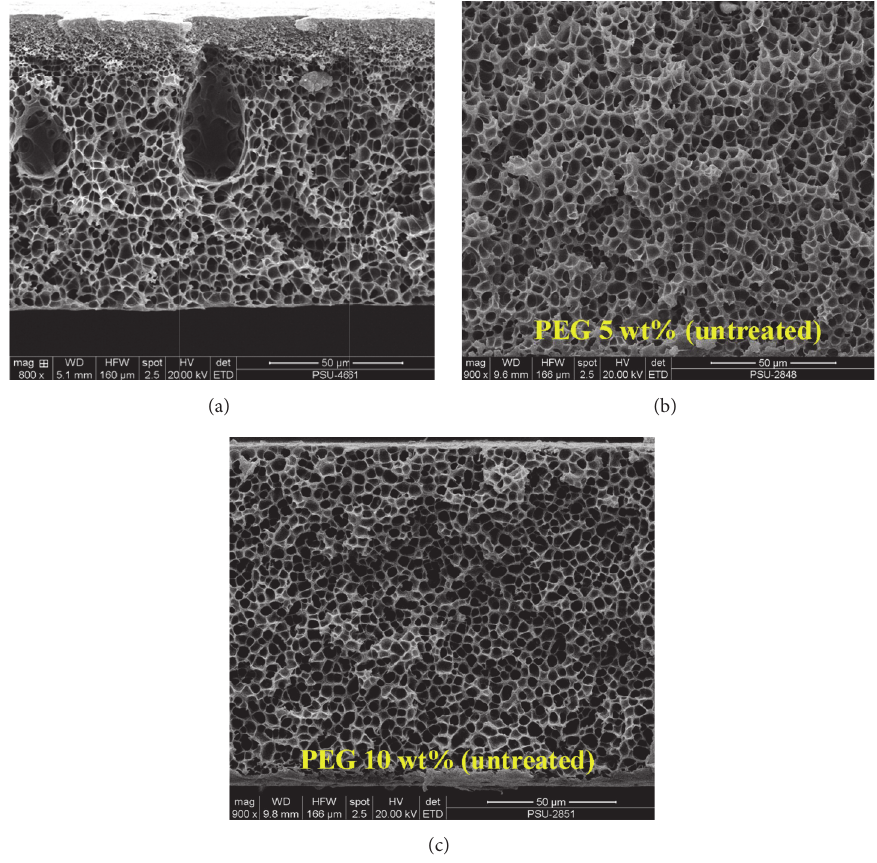
Figure 4: SEM micrographs: cross-sectional structure of pure PSF (a), PSF/PEG 5wt% (b), and PSF/PEG 10wt% (c) membranes.